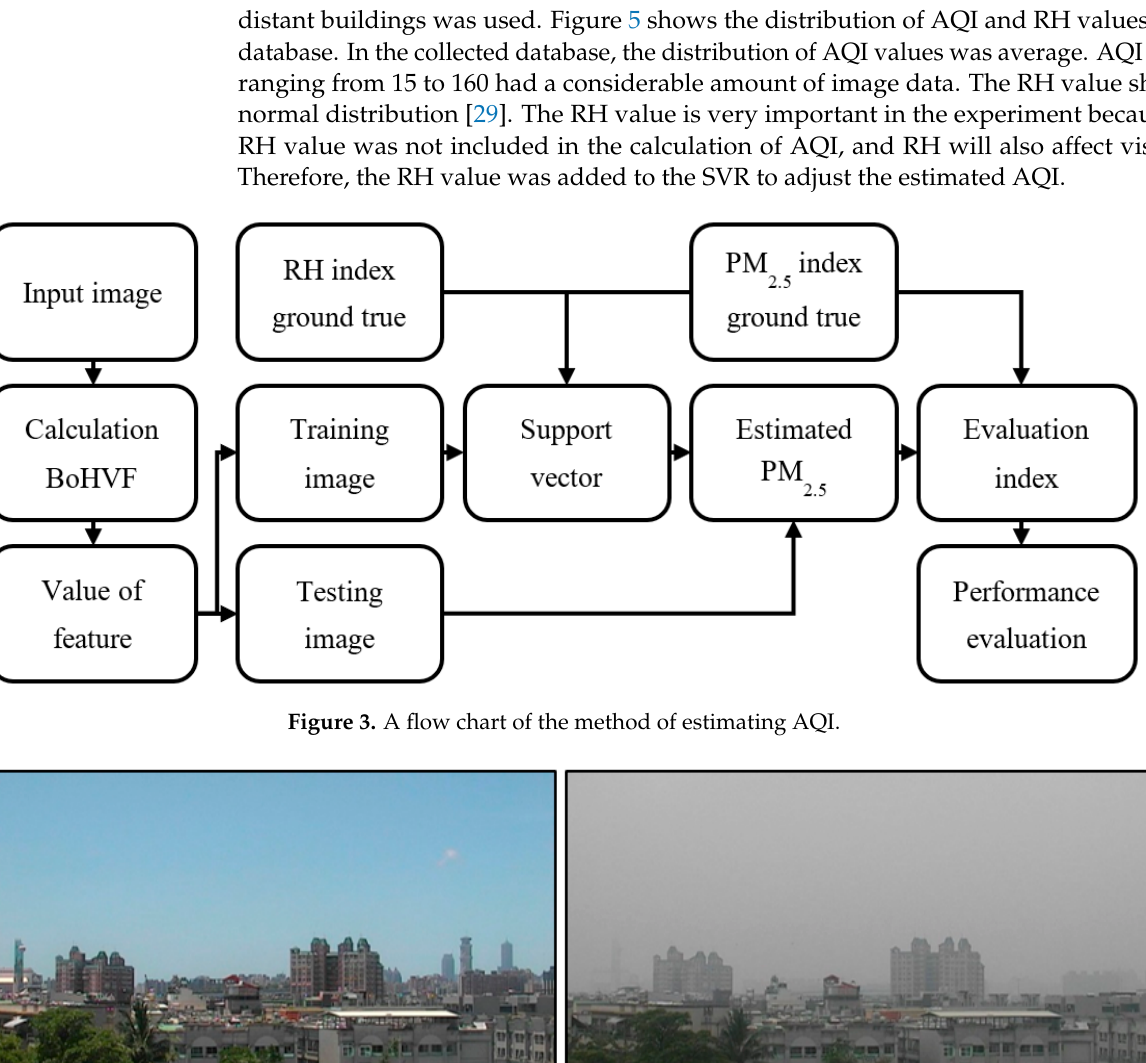
Figure 3. A flow chart of the method of estimating AQI.